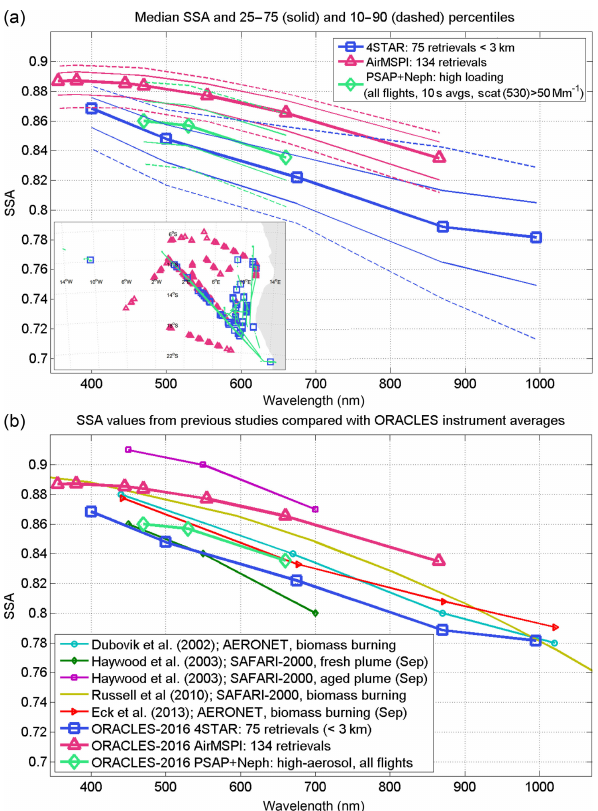
Figure 10. The difference between SSA measured in situ versus retrieved from 4STAR (in situ – 4STAR) as a function of 4STAR (a) AAOD and (b) AOD, respectively.